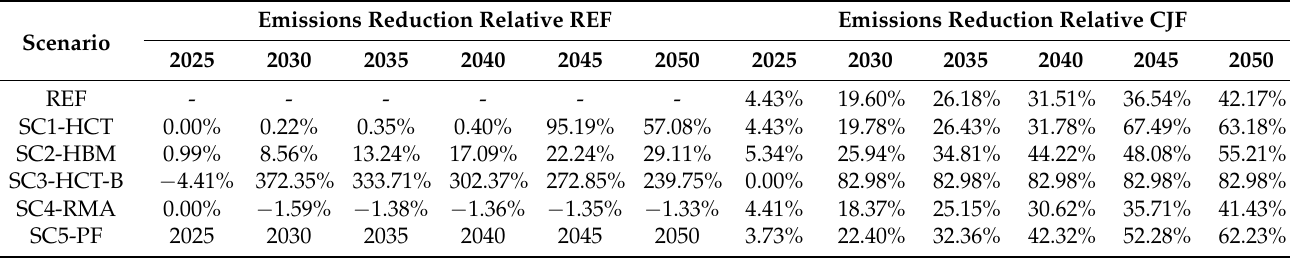
Table 11. Annual emissions reduction potential from all scenarios relative